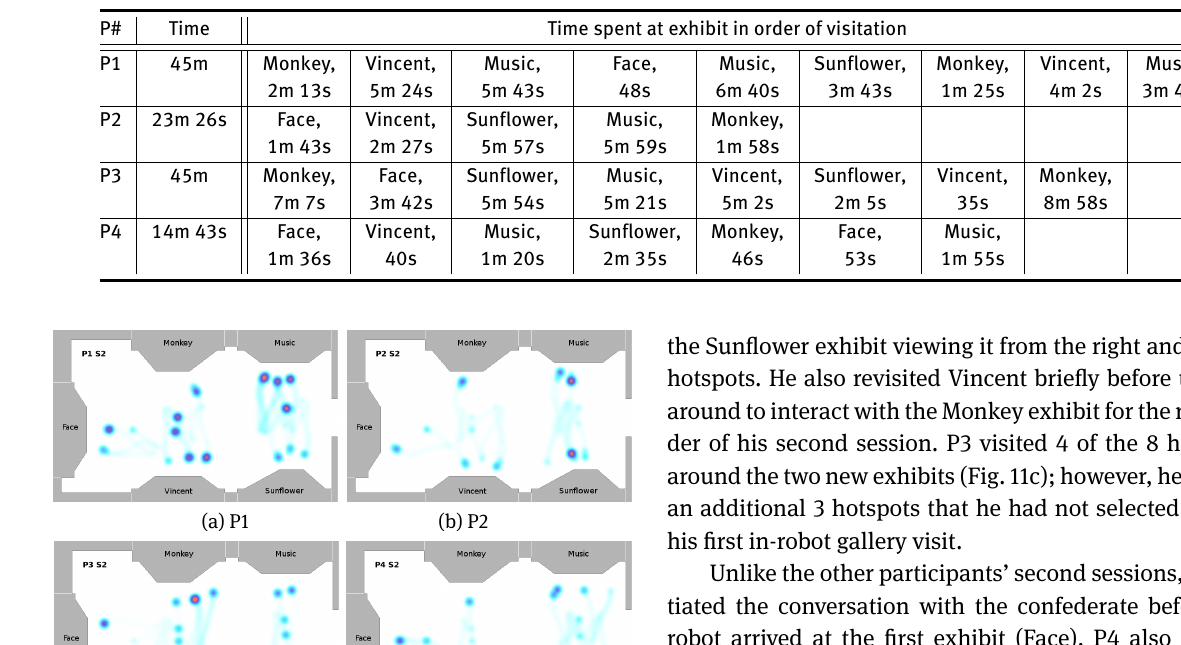
restarted during the second; the audio stream from the VGo App remained, so the confederate and P2 continued their conversation during these two breaks. The total time P2 spent in her second in-robot visitation was 23 minutes and 26 seconds, not including the time needed to restart the robot.